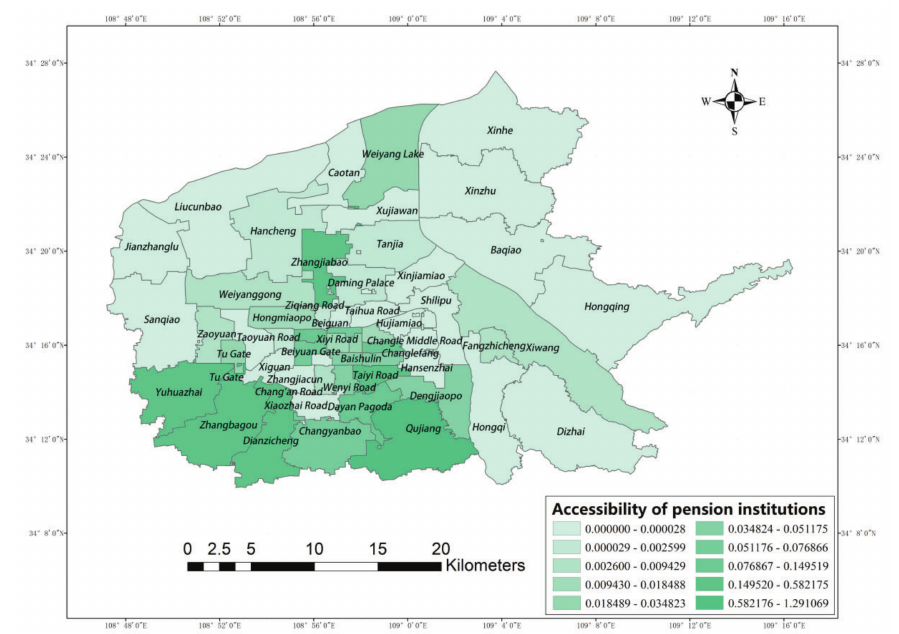
Figure 7. Main urban area accessibility